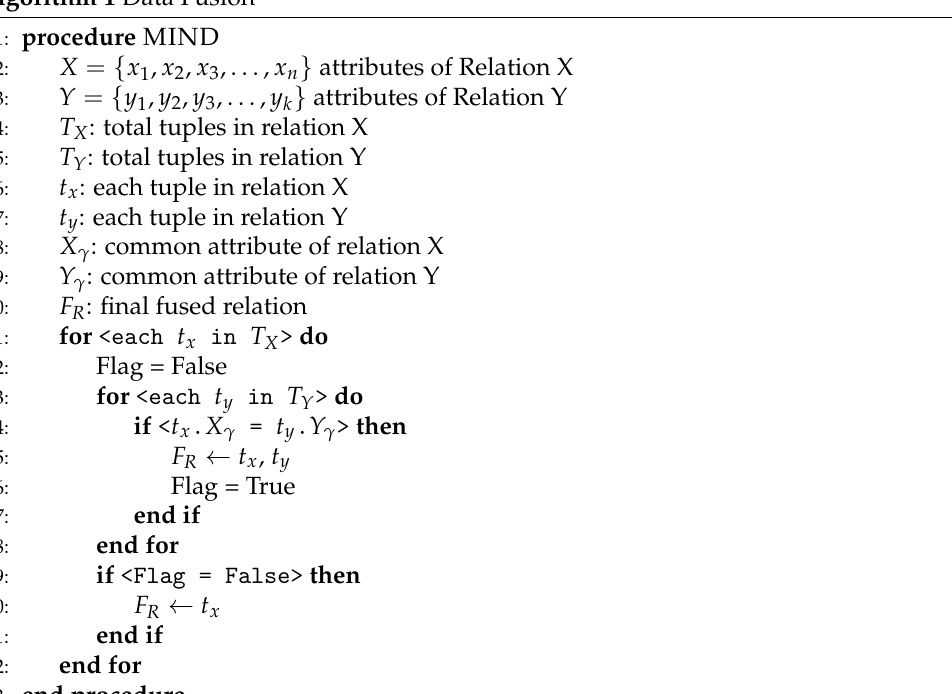
Algorithm 1 Data